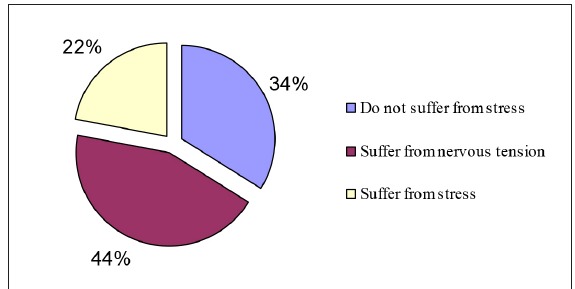
Fig. 3. Distribution of respondents according to the L.G. Reeder stress inventory (in percent)